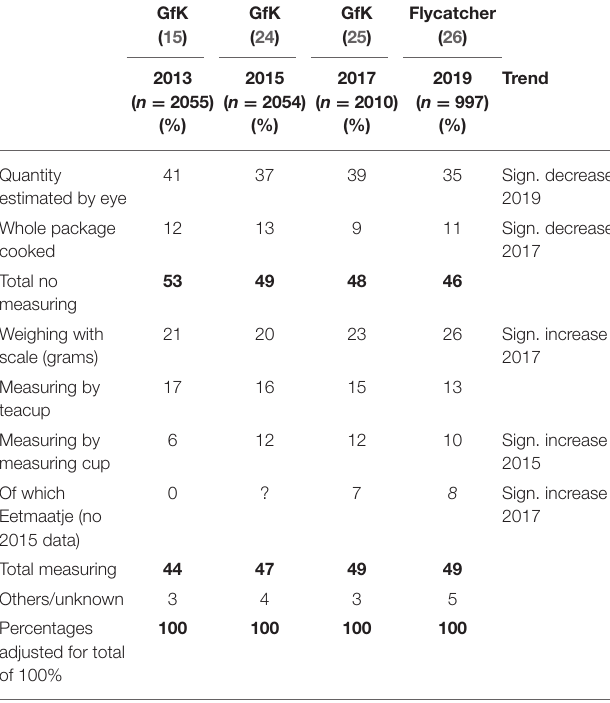
TABLE 4 | Consumers who measure and do not measure pasta, including whether they measure dry food using a scale, a teacup, a measuring cup, or the Eetmaatje (before and after the introduction of the Eetmaatje),